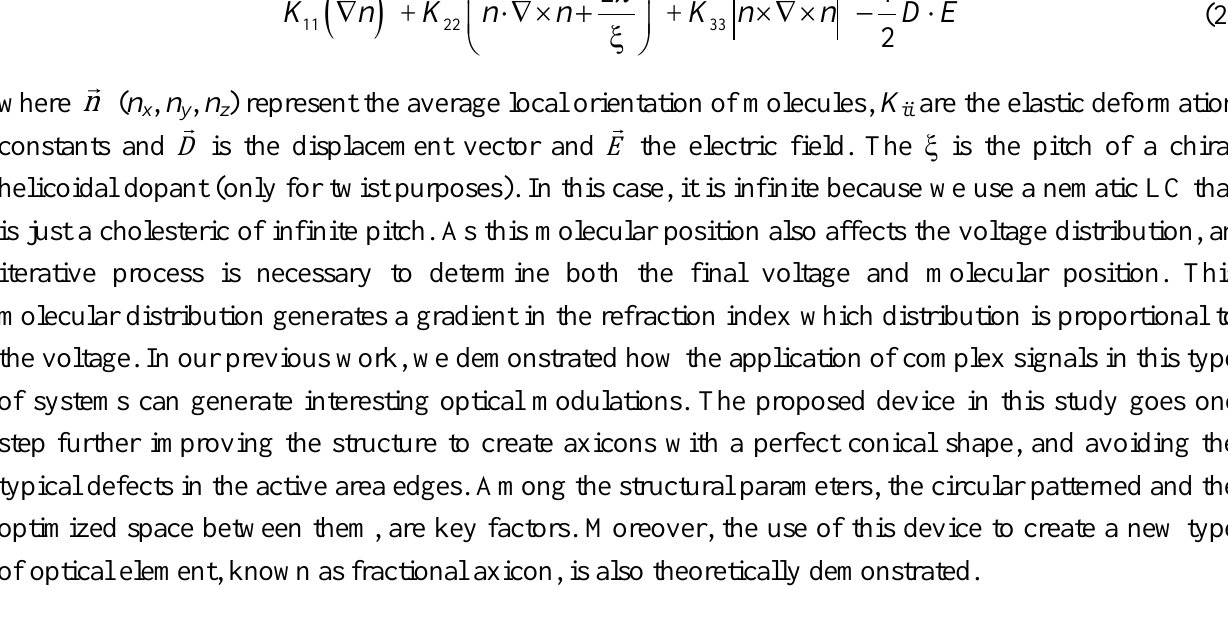
Figure 1. Scheme of the proposed structure. ( a ) Top view and ( b ) 3D diagram of the substrates arrangement. Note drawings are not to